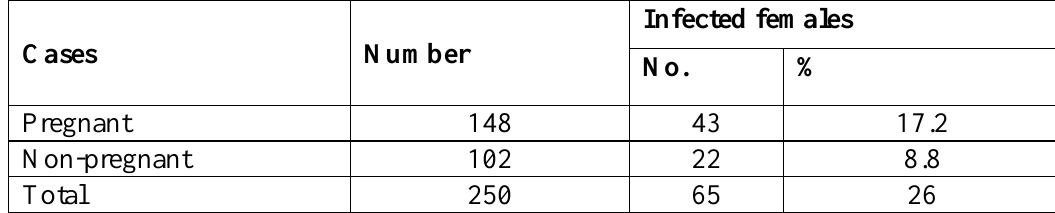
Table (1): Distribution of Trichomonas vaginalis among pregnant and non-pregnant females